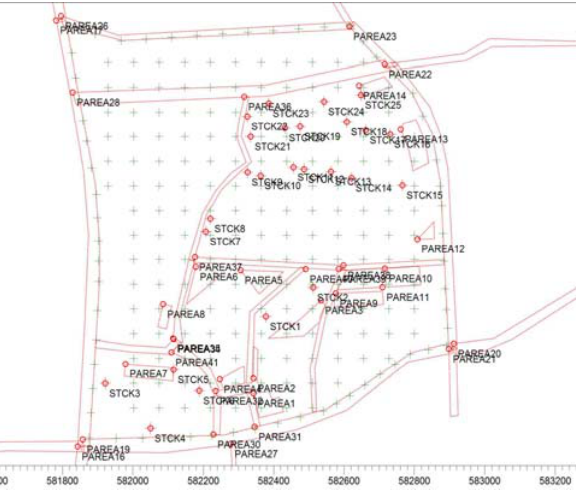
Fig 3 . Pollution measuring points in studied area